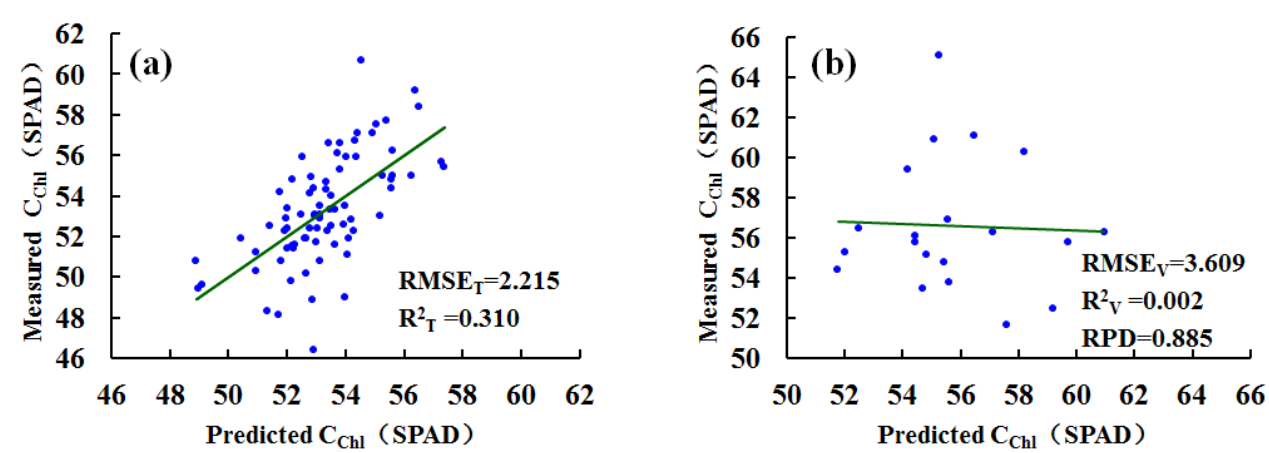
Figure 5. The estimated results of SPAD value for ( a ) training set and ( b ) validation set at flowering stage.